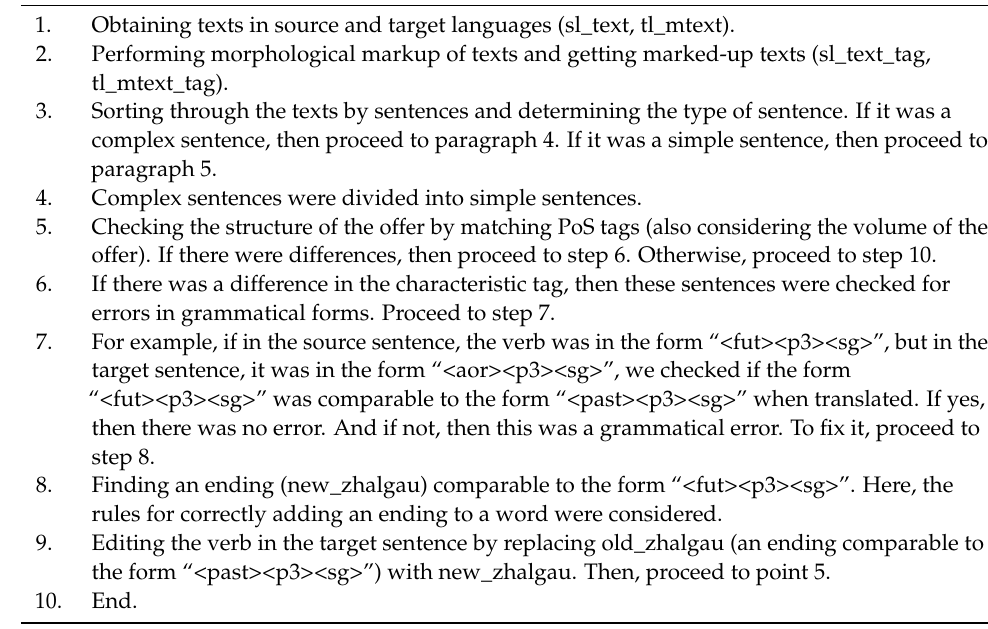
Algorithm 2 : The algorithm for editing a complex